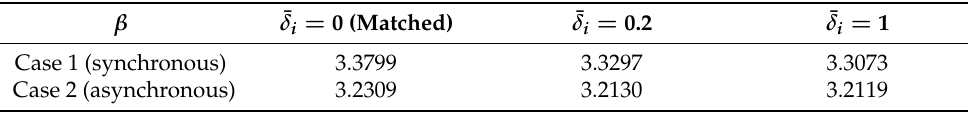
Table 3. Comparison of dissipativity performance β for different ¯ δ i